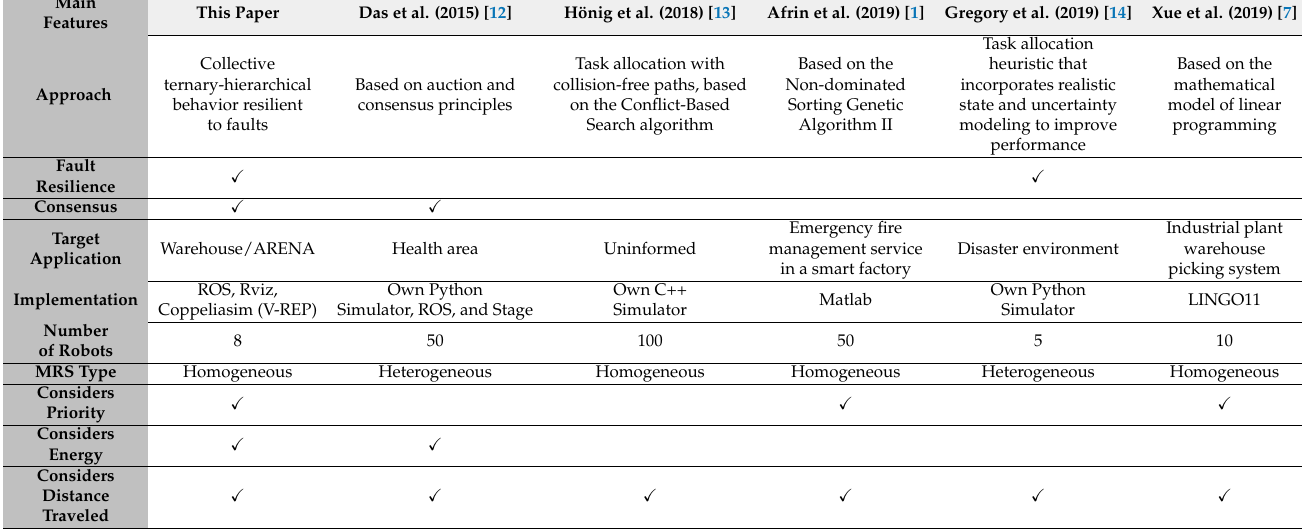
Table 1. Comparison with related works—Part 1.